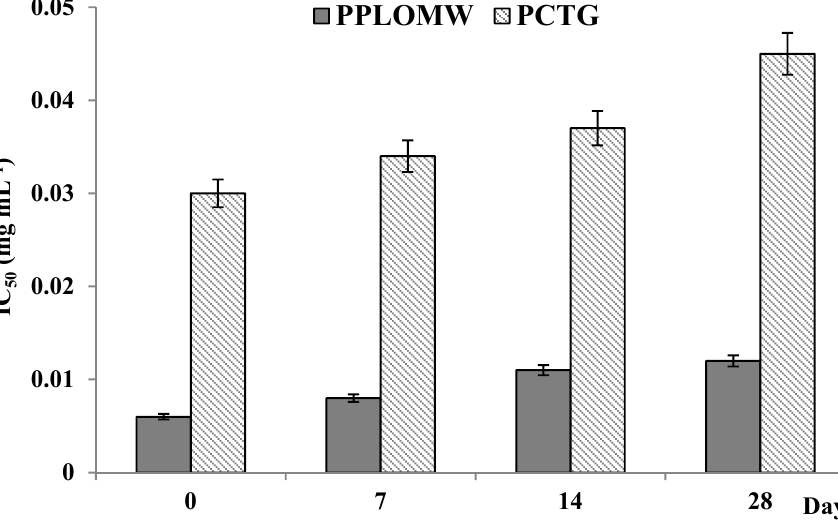
Figure 7. IC 50 trend as function of the time of PPLOMW and PCTG.